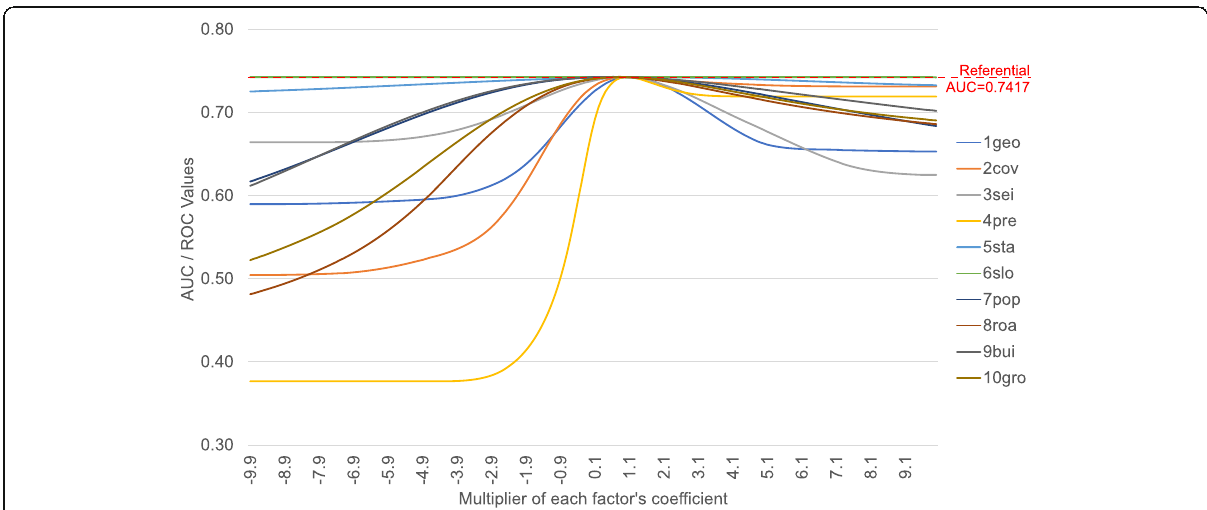
Fig. 5 Univariate sensitivity analysis for LOGIT model (percentile discretization) showing AUC values as a metric of the impact of coefficient variations on the model performance. Legend: Lines represent factors: 1geo = lithology (electric blue), 2cov = land use/vegetation coverage (orange), 3sei = seismicity (light gray), 4pre = precipitations (yellow), 5sta = soil stability (light blue), 6slo = slope (green), 7pop = population (dark blue), 8roa = road density (brown), 9bui = floor area (dark gray) and, 10gro = building footprint area (ochre). X-axis shows the multipliers of each factor ’ s coefficient and Y-axis shows the AUC/ROC values. The referential AUC value is shown in the dashed red